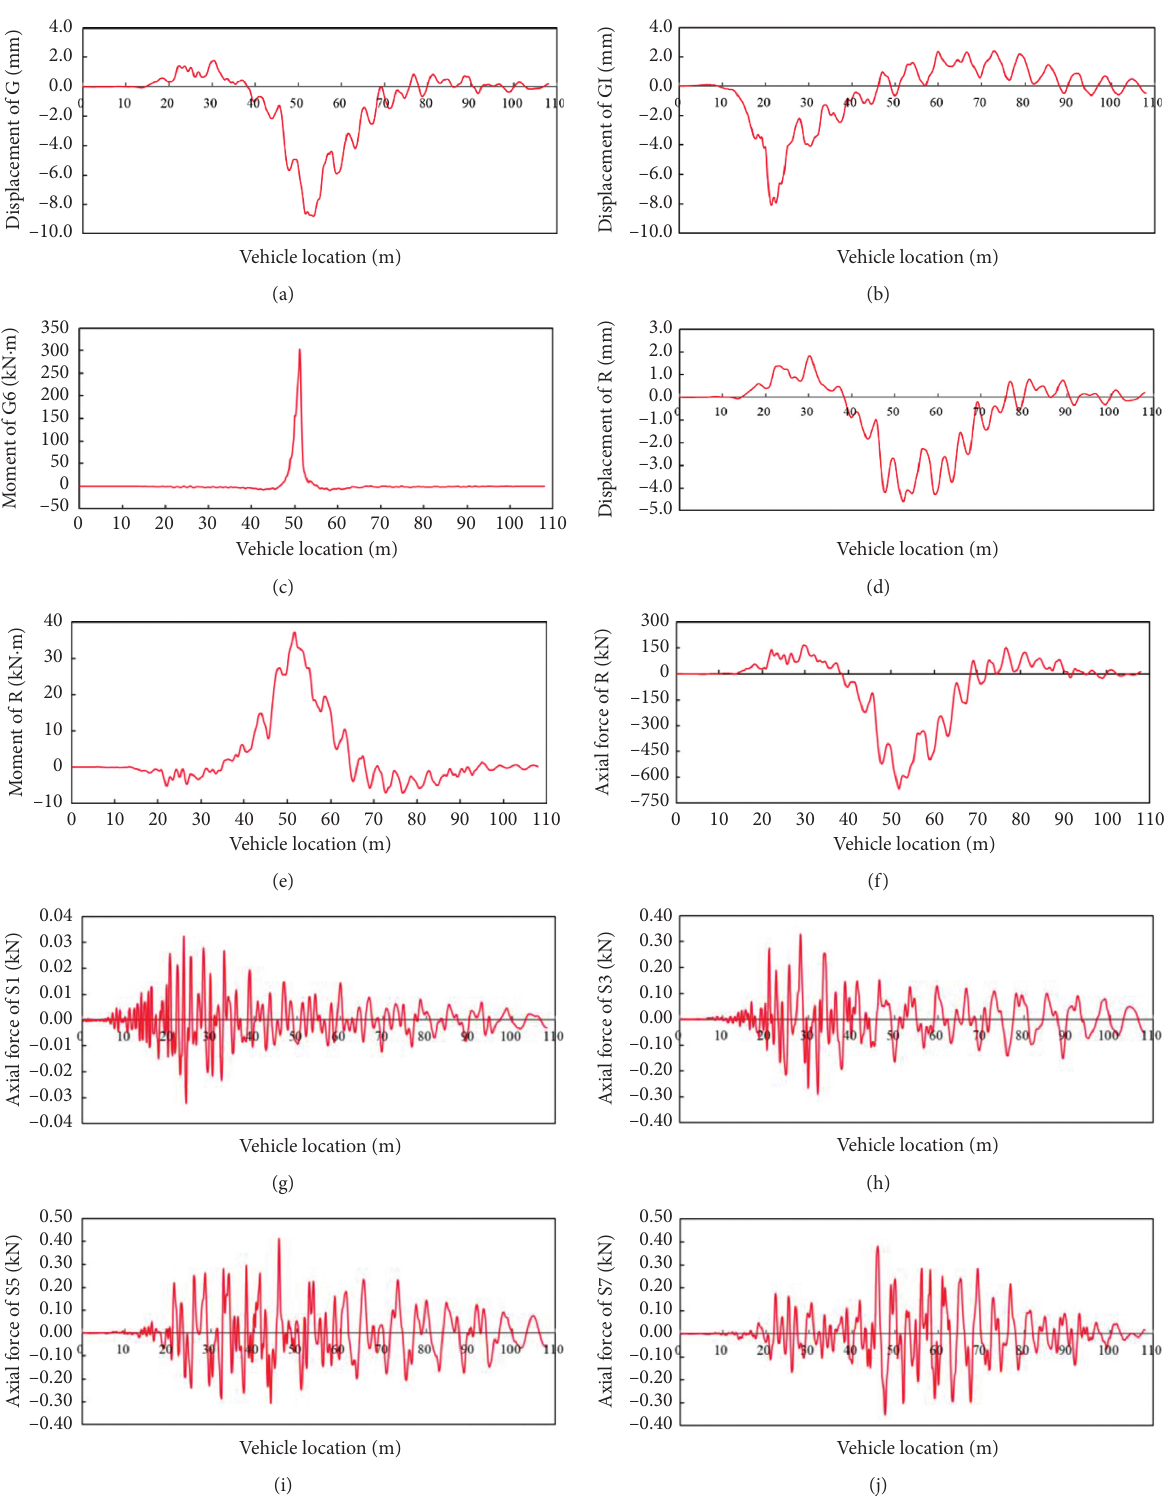
Figure 9: Dynamic responses ( v � 15m/s, pavement roughness is the average): (a) displacement of G ; (b) displacement of G1; (c) moment of G6; (d) displacement of R ; (e) moment of R ; (f) axial force of R ; (g) axial force of S1; (h) axial force of S3; (i) axial force of S5; (j) axial force of